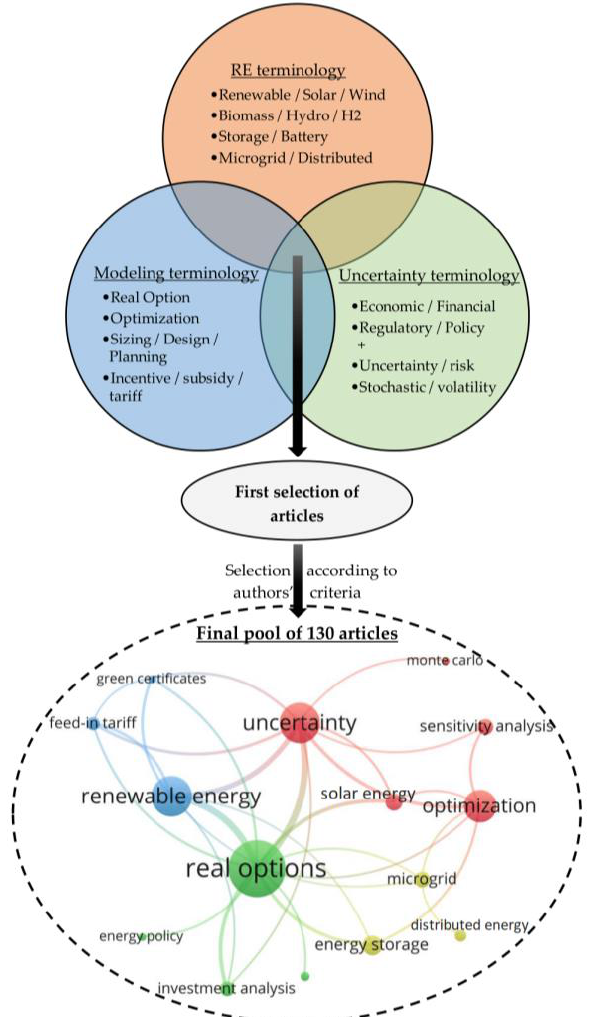
Figure 1. Methodology schematization and keyword network of the reviewed articles.